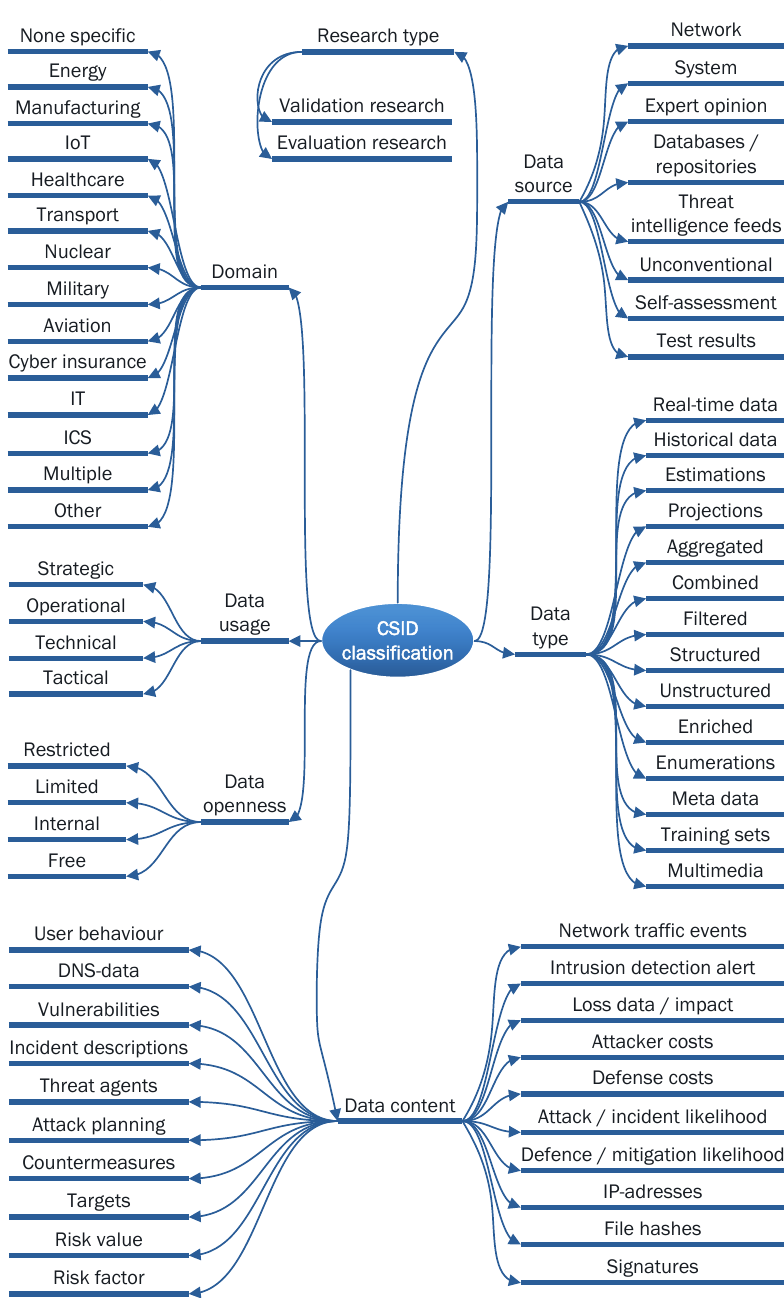
Figure 2. The Cyber Security Indicator Data (CSID) classification